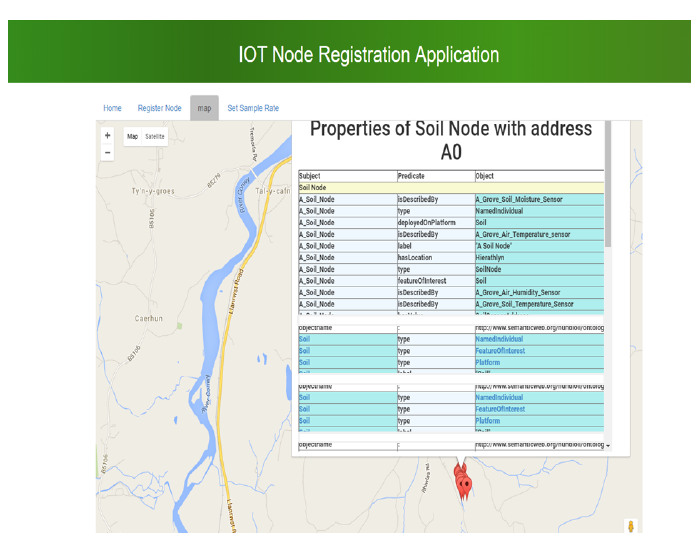
Figure 18. Map showing semantically enriched IoT